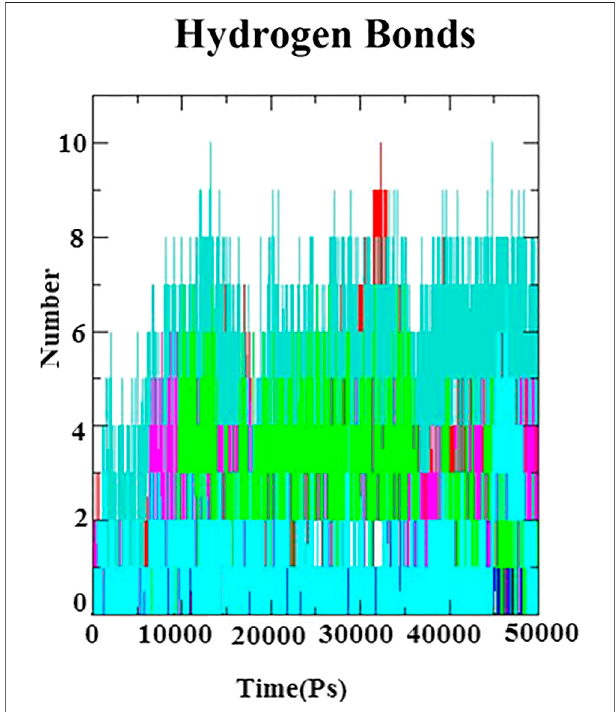
FIGURE 6 | Hydrogen bond plot for N-protein – inhibitor complexes (nine complexes) during the 50 ns simulation as a function of timescale in